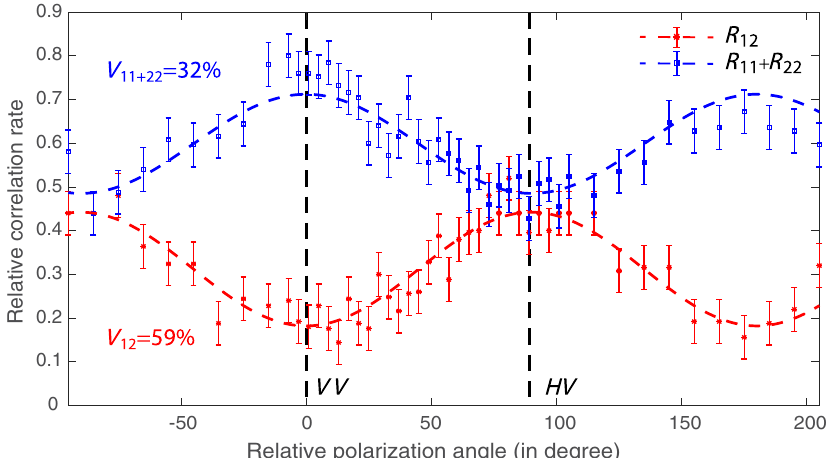
FIG. 5. Correlation ratios as a function of the polarization angle between the two SPDC beams. Red stars and blue squares correspond, respectively, to correlations between the two images ( R 12 ) and within single images ( R 11 þ R 22 ). The dotted curves correspond to nonlinear fits of the experimental